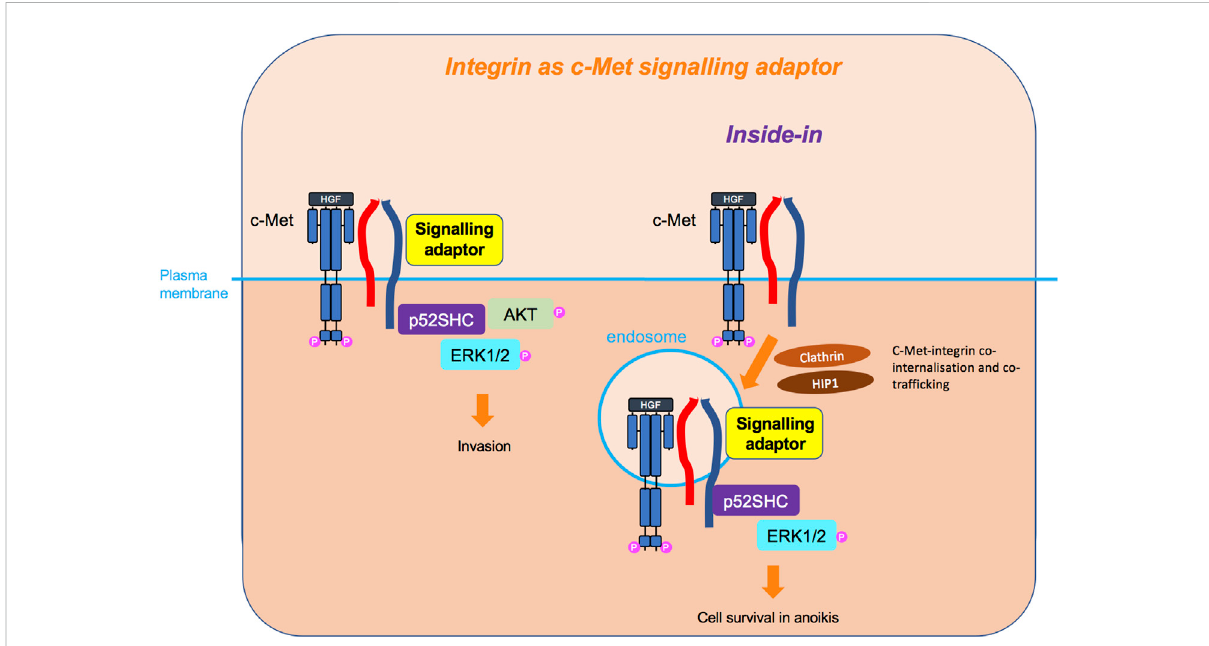
FIGURE 7 Integrin as c-Met signalling adaptor and the inside-in signalling. Integrins, so far β 4 and β 1, can also act as adaptors independently of their extracellular domainand adhesive property, linking c-Met to downstream signalling molecules, such as p52SHC adaptor, leading to ERK1/2 and AKT sustained signalling. For the β 1 integrin, this cooperation has been shown to occur on an endomembrane, following the co-internalisation of c-Met and β 1. This inside-in signalling triggers cell survival independently of